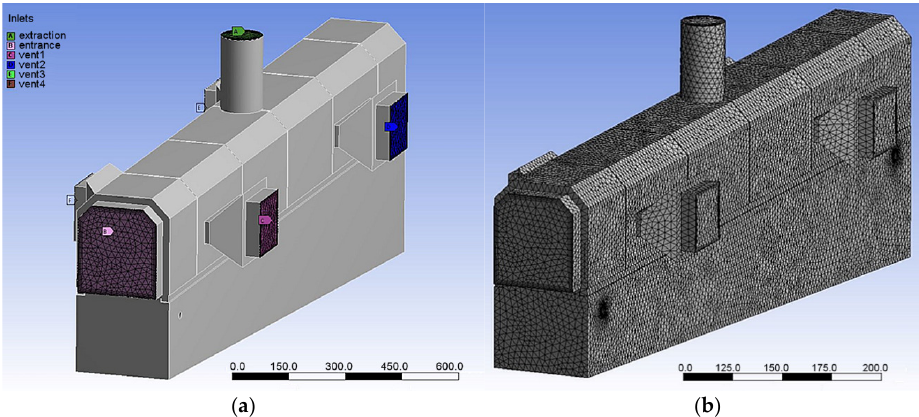
Figure 3. Numerical models in the flow simulation: ( a ) CAD-based model of cooling chamber of the laboratory cooling simulator, and ( b ) finite element mesh. In order to reproduce the actual cooling conditions, a sequence of eight stages was composed, i.e., (1) transfer from the forging press to the cooling line, (2) cooling in accel- erated air of approximate rate 15 m/s, in which sprayer domains with the previously de- termined α coefficient were used (Figure 4), passing over the sample with speed of con- veyor (Figure 4b), thereby forming three periods of spray quenching with intervals of fan- cooling acting on surfaces outside the sprayers (Figure 4c,d), followed by natural air cool- ing. The experimental plots of temperature measured in selected points of the part are presented in sec.3.2 when compared to those calculated numerically for thermocouples T1 and T3 (as the plot from thermocouple T1 was the same as T2 and similarly, T3 and T4; and any deviations were attributed to time shift during cooling, one of each pair is repre- sentative for corresponding areas by the symmetry). ( a )